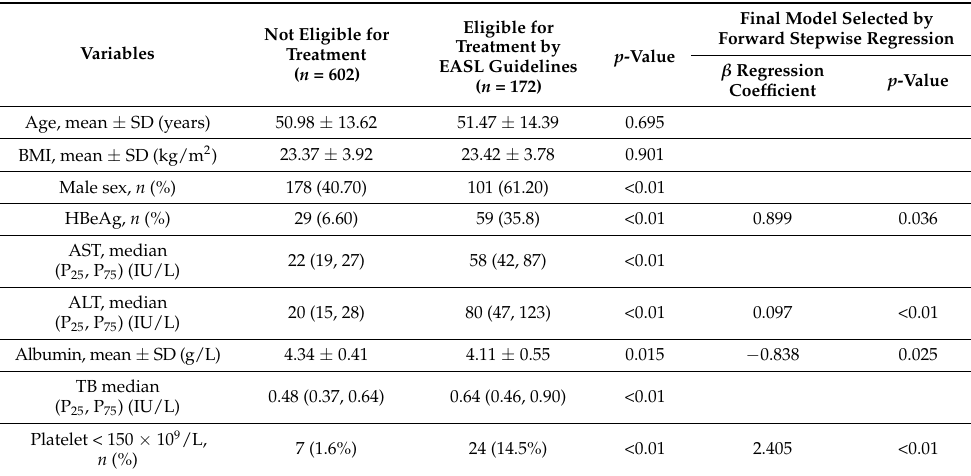
Table 2. Predictors for treatment eligibility in the derivation cohort ( n =